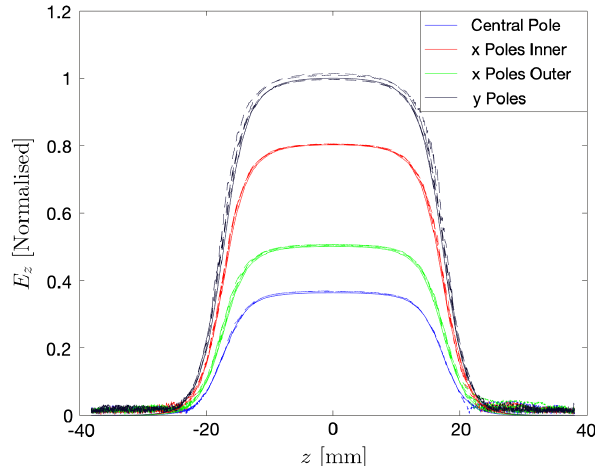
FIG. 14. Comparison of bead pull measurements of the electric field compared to simulation.